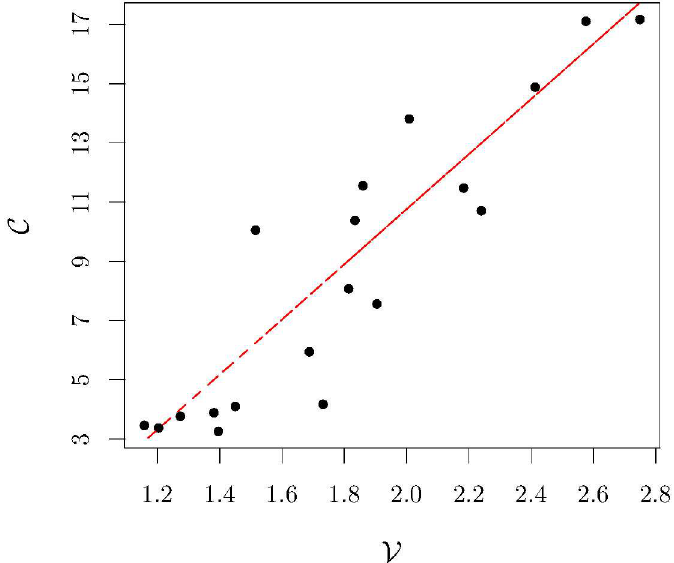
Fig 6. Relation between concavity and the average daily trading volume for AT&T Inc. The dots represent the empiricaldata and the line, which has a slope equal to 9.45 ± 1.02, shows there is a good agreement between our linear relation and the data (the correlationcoefficient R of this fit is equal to 0.85). Both quantities are scaled by a factor 10 5